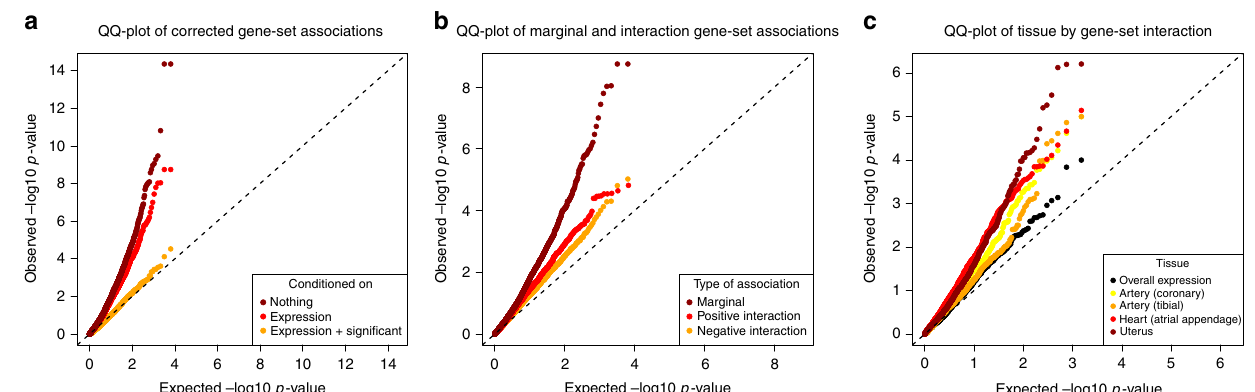
Fig. 3 Global QQ-plots of associations for pulse pressure. a Comparison of gene-set associations corrected for other effects. Shown are associations with no corrections (step 1), associations corrected for overall and tissue-speci fi c gene expression (step 2), and associations additionally corrected for all signi fi cant and retained gene sets listed in Table 2. When correcting for gene expression, the associations for miRNA target sets were also corrected for general miRNA target status. b Comparison of the overall levels of marginal and interaction association. Marginal associations are corrected for general confounders (step 2); the interaction associations are from the exploratory interaction analysis (step 6). c Comparison of tissue by gene set interactions for different tissues. For all of the tissue-speci fi c analyses, each interaction was also conditioned on the interaction between overall expression and the gene set. For all three plots, corresponding fi gures for all of the phenotypes can be found in Supplementary Figures 3 –